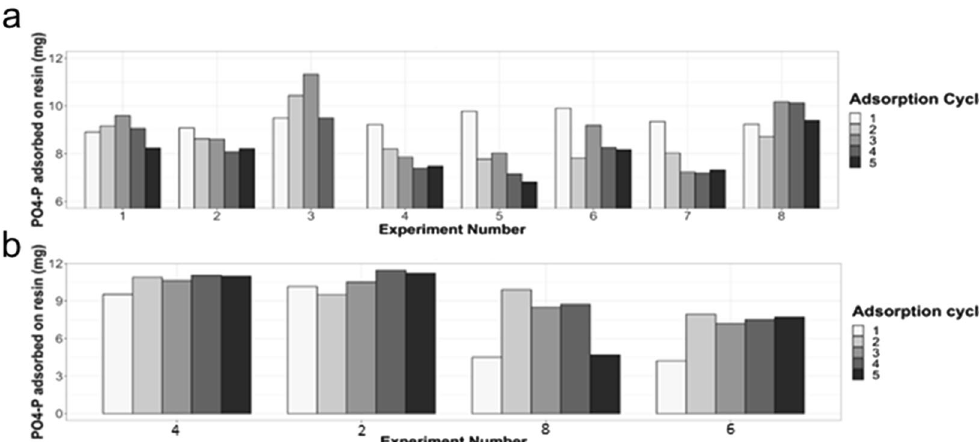
Fig. 3 Phosphorus adsorbed on the resin (mg) over fi ve microcolumn adsorption – desorption cycles. a Experimental set C; b Experimental set